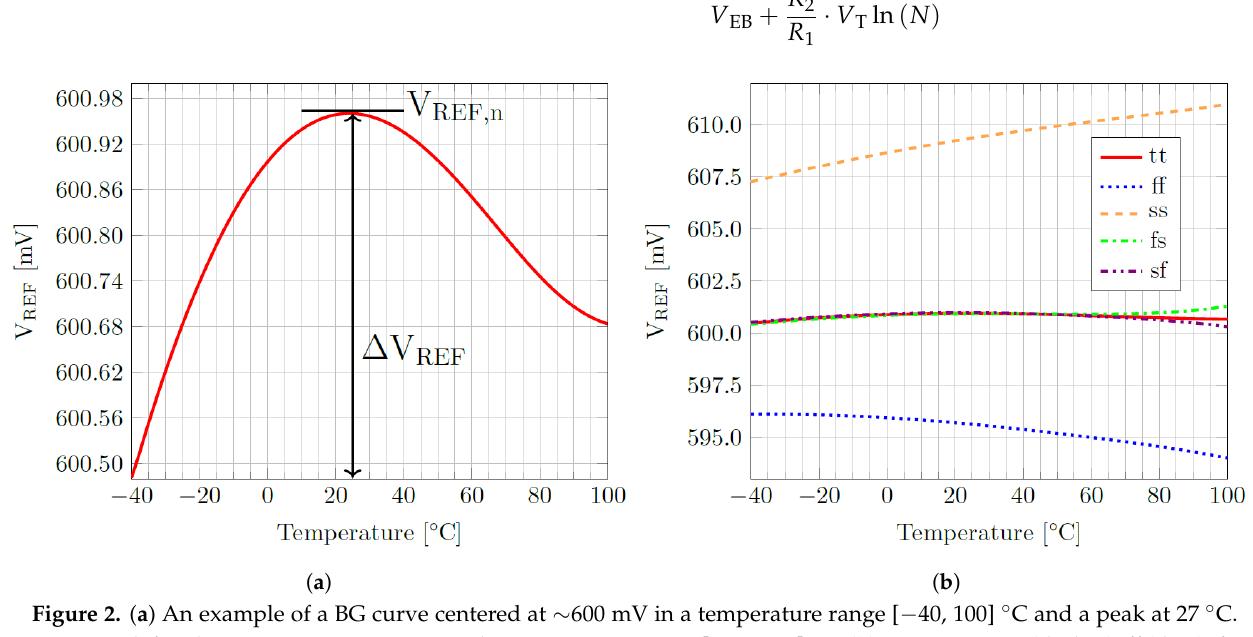
− 40, 100] ◦ C. ( b ) Worst cases ss (dashes), ff (dots), fs